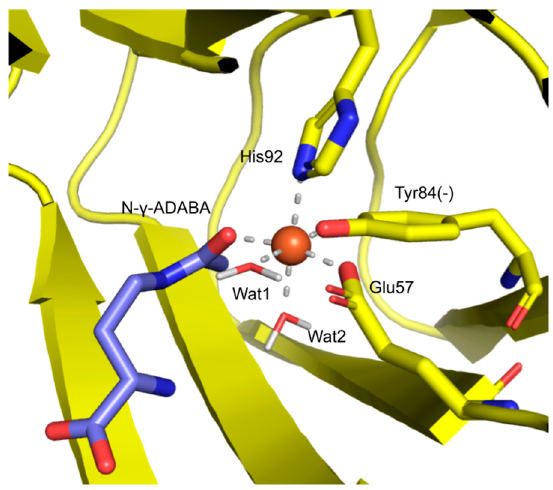
Figure 13. Zoom into the octahedral geometry around the Fe 2+ ion in a 12-6-4-LJ nonbonded model. Two water molecules, Wat1 and Wat2, added as Fe 2+ coordinating ligands.